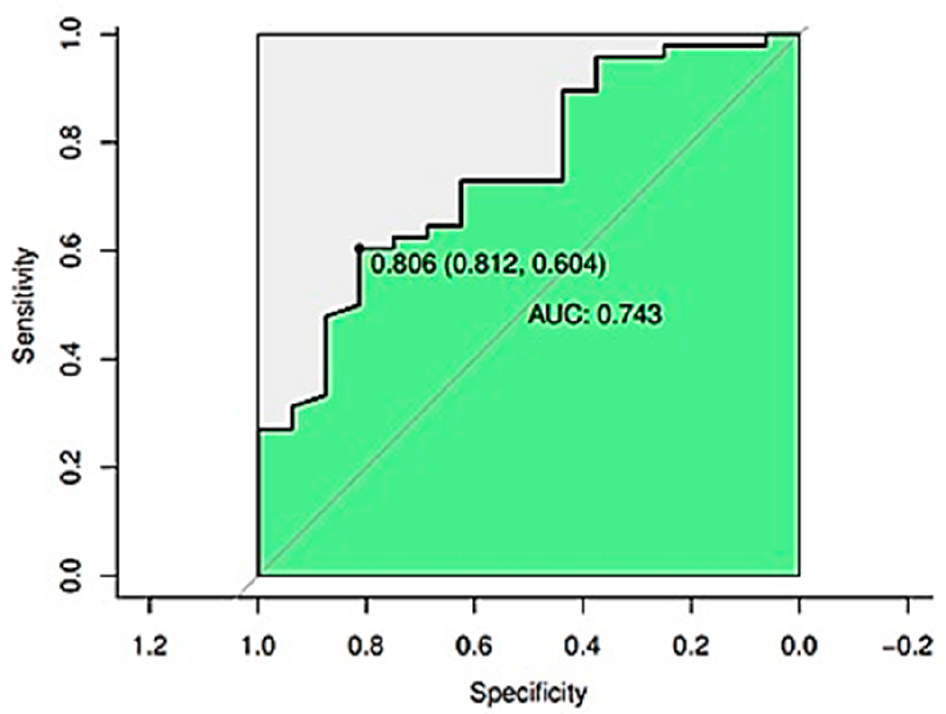
Figure 2. ROC curvature of the statistical model.